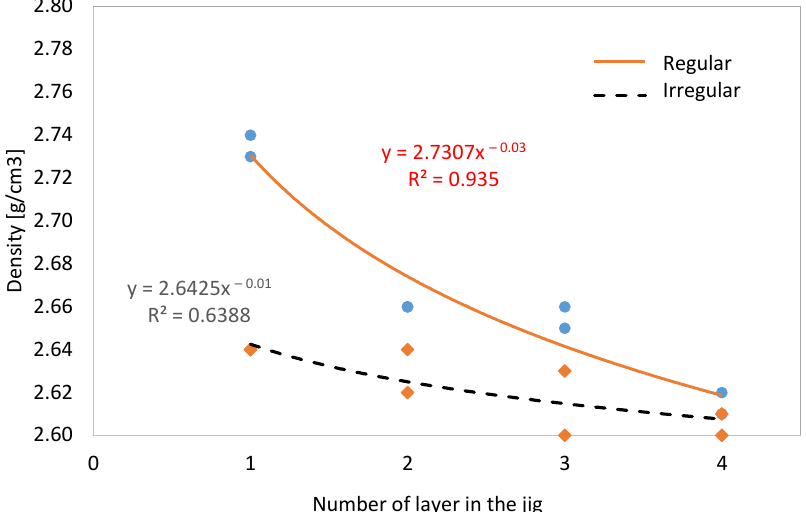
Figure 7. Model of separation density calculated separately for regular and irregular particles. Density models show that for regular particles the power at x is greater in absolute numbers, but the second coefficient shows no impact on the shape of particles. Models of absorbability show that power at x is also greater for regular particles. In this case this value is greater than zero. Higher impact of the second coefficient can be observed, and it is higher for irregular particles (2.9632) than for regular ones (1.4325). In general, the modeling results justify the approach consisting in run of jig beneficiation process separately